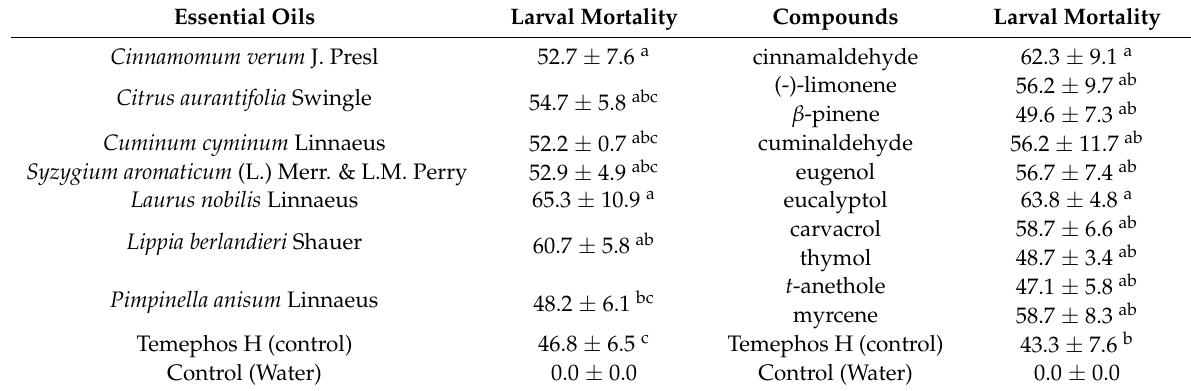
Table 4. Percentage of Culex quinquefasciatus larvae mortality upon exposure to water contaminated by LC 50 doses.